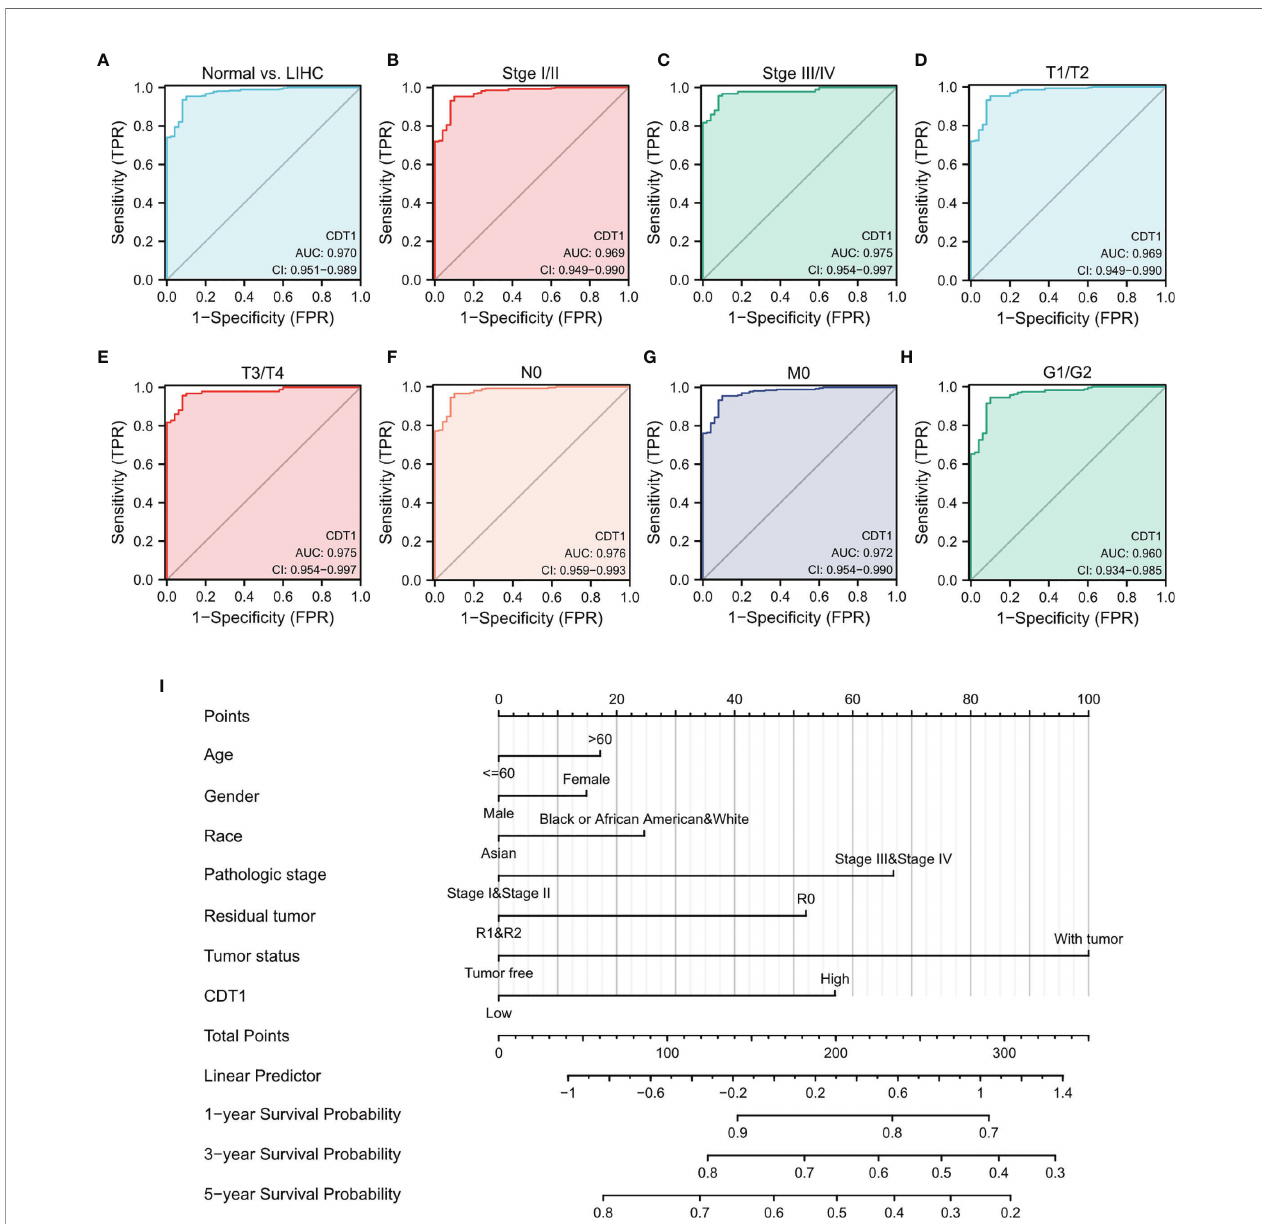
FIGURE 5 | Diagnostic value of CDT1 mRNA level in HCC. (A) ROC curve for CDT1 in HCC and normal liver tissue. (B – H) Subgroup analysis for stage I/II, stage III/ IV, T1/T2, T3/T4, N0, M0, and G1/G2. (I) Nomogram predicting the probability of patients with 1-, 3- and 5-year overall